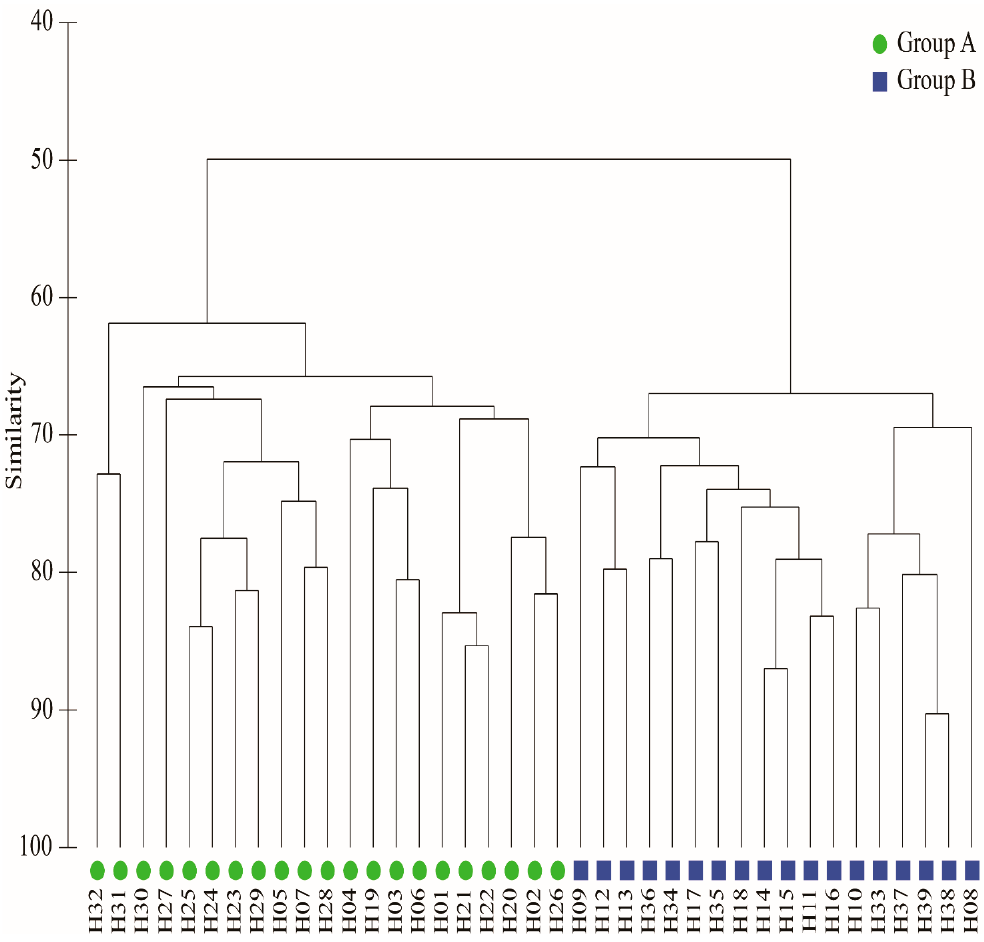
Figure 3. Cluster analysis of the 39 sampling sites in the Hun River Basin based on the fish species relative abundance data.